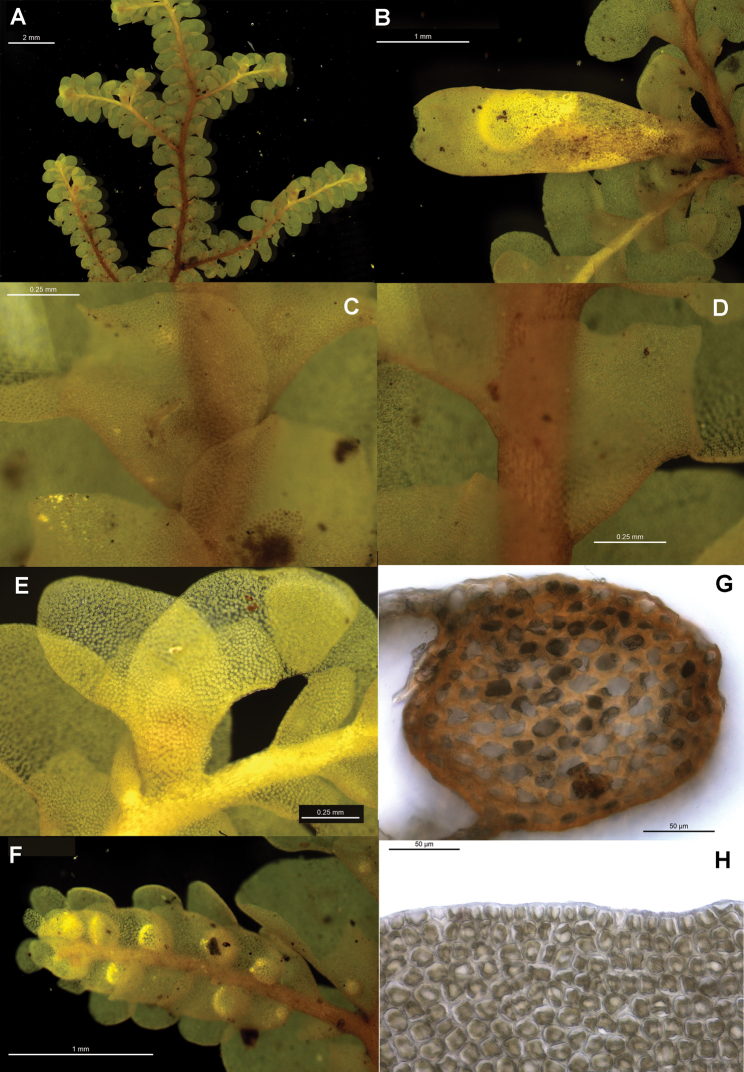
Radula mittenii pictures 1. A Ventral view of female shoot B Immature perianth. C, D Ventral view of lobules on primary shoots, C showing maximal extent of imbrication, D showing typical E Gynoecium F Androecium G Transverse sections of stems from primary shoot H Leaf-lobe marginal cells. All from NSW897201